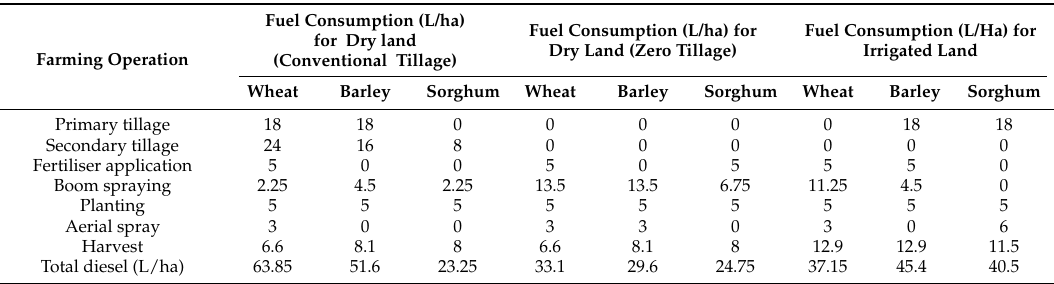
Table 5. Fuel (diesel, L/ha) consumption (except irrigation fuel) for three high value grain crops in Northern Grain Region (From Darling Downs region).